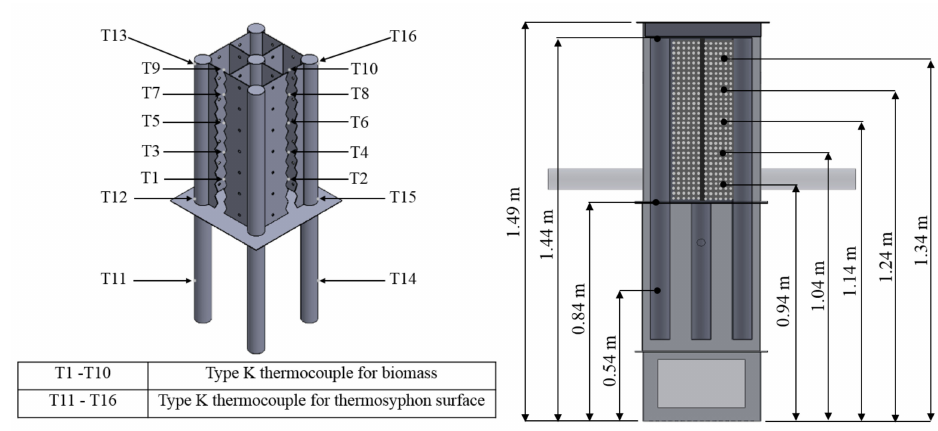
Figure 2. Detail of thermocouples installation.